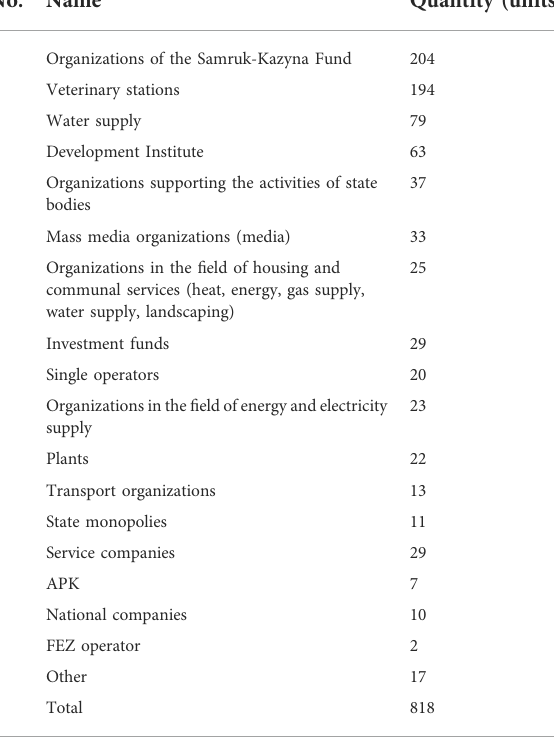
TABLE 3 State and quasi-state companies in the non-social sphere of the Republic of